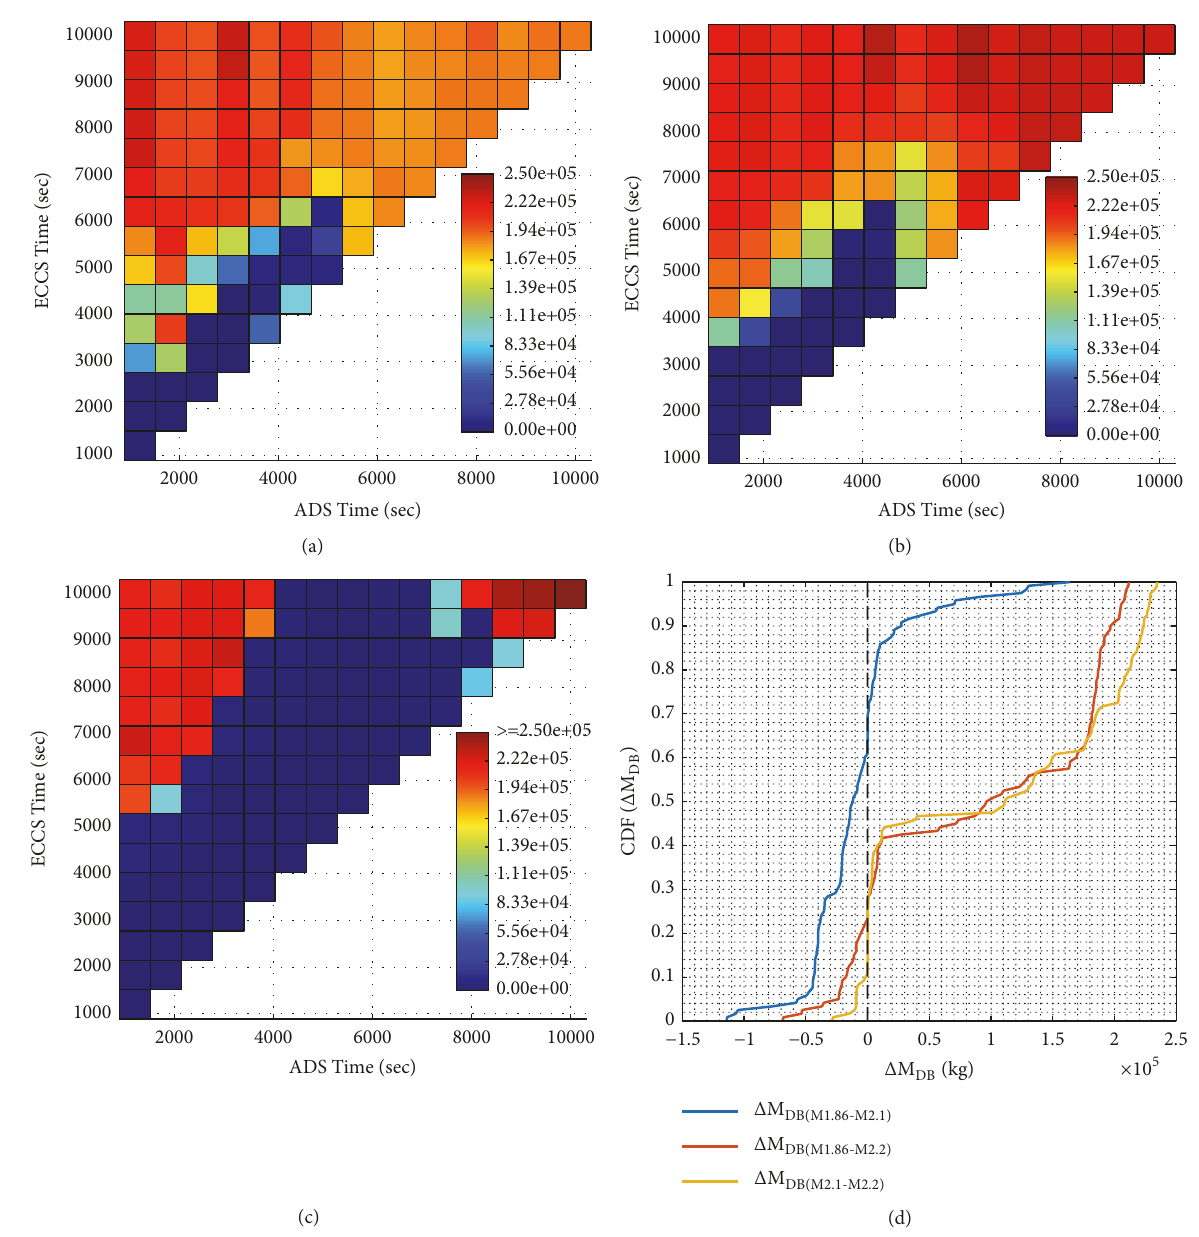
Figure 8: Debris mass in Nordic BWR lower plenum at 𝑇 𝑡𝑟 as a function of ADS time and ECCS time obtained with (a) MELCOR 1.86, (b) MELCOR 2.1, and (c)MELCOR 2.2.(d) Cumulativedistributions of the differencesin the debris mass in LP at 𝑇 𝑡𝑟 between differentMELCOR code